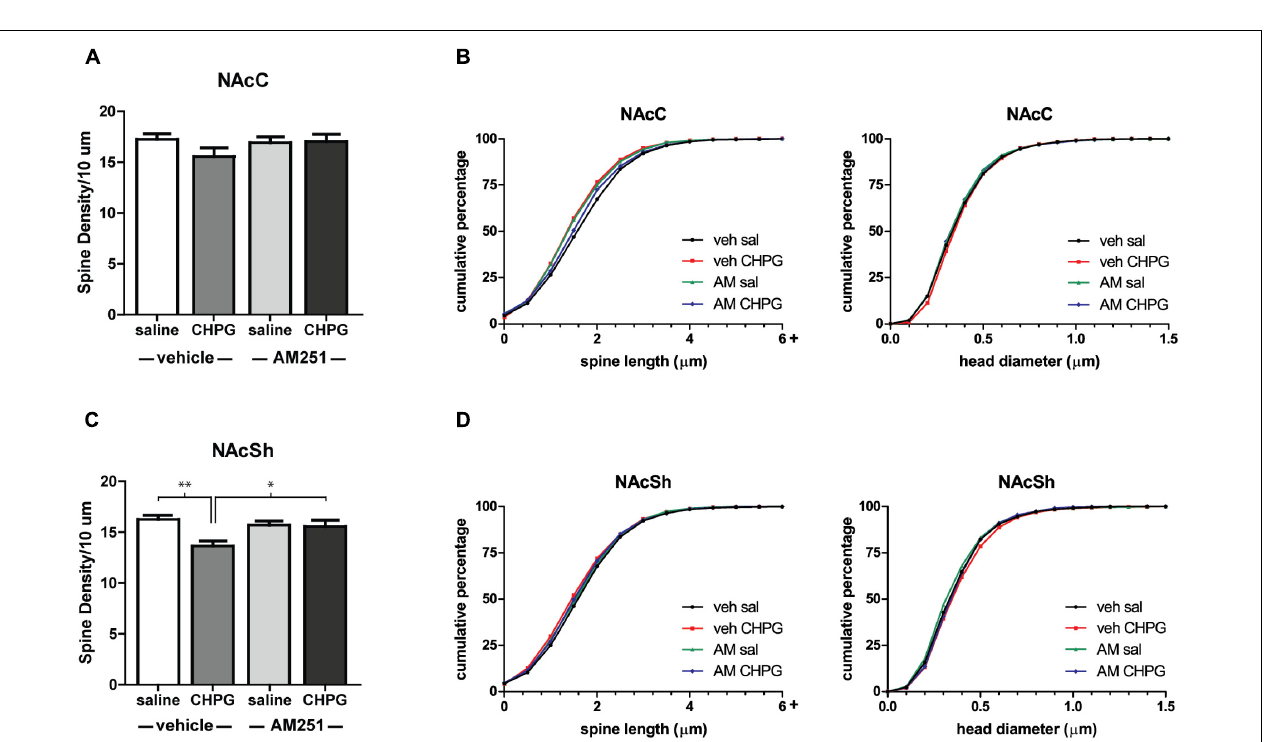
FIGURE 5 | Local mGluR5 activation decreases NAcSh spine density and is endocannabinoid dependent. Spine density and morphology were measured in male rats receiving systemic veh/AM251 (1 mg/kg) 30 min prior to local injection of veh/CHPG (10 µ g/side) into the NAc. (A) Average spine density per 10 µ m of MSNs in the NAcC 24 h after drug infusion. (B) Spine morphology of MSNs in the NAcC 24 h after drug infusion as assessed by binned cumulative probability distributions of spine length and head diameter. (C) Average spine density per 10 µ m of MSNs in the NAcSh 24 h after drug infusion. (D) Spine morphology of MSNs in the NAcSh 24 h after drug infusion. n = 7–8 animals per group with spine density averaged from 6 to 9 dendritic segments per each subregion for each animal, ∗ p < 0.05, ∗∗ p <